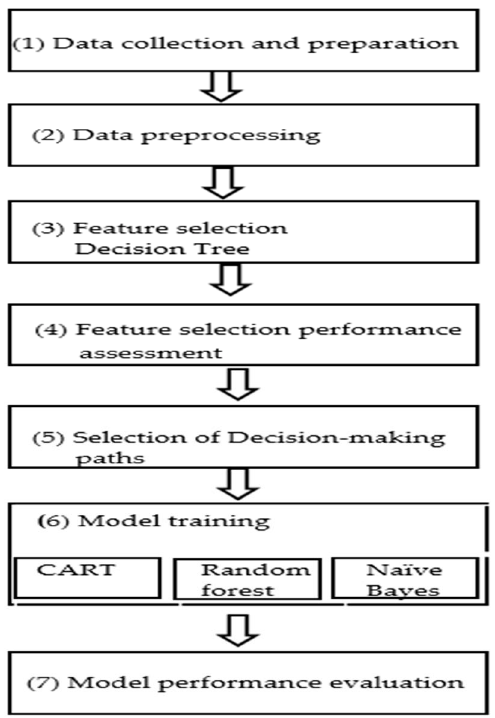
Figure 1. Research process of the study.